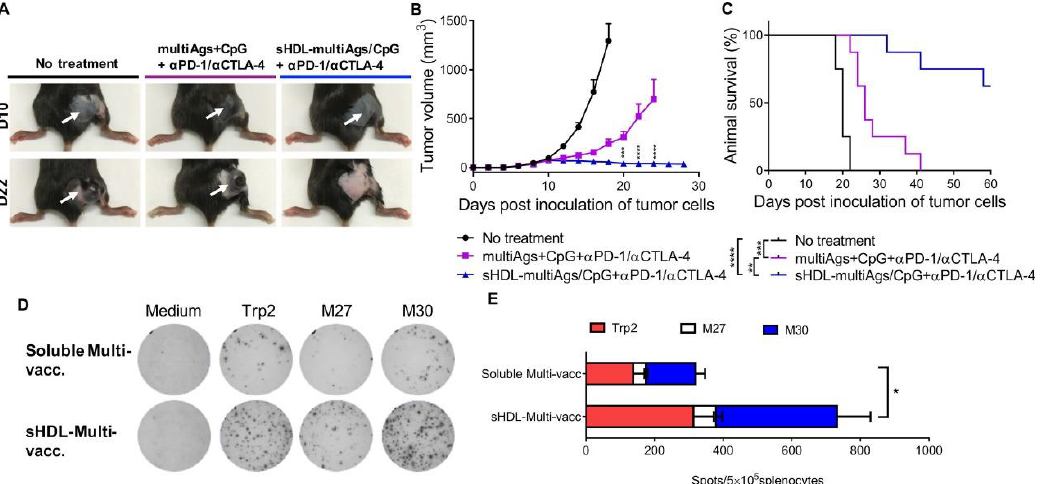
Figure 6. Therapeutic effects of the combination of vaccine nanodiscs and immune checkpoint blockers. ( A ) Images of tumor-bearing mice at the beginning of treatment (day 10) and during treatment (day 22). ( B ) Mean tumor growth over time. ( C ) Animal survival over time. ( D ) Images of ELISPOT wells. ( E ) The number of tumor antigen-specific IFN- γ + spots [204]. * p ≤ 0.05, ** p ≤ 0.01, *** p ≤ 0.001, **** p ≤